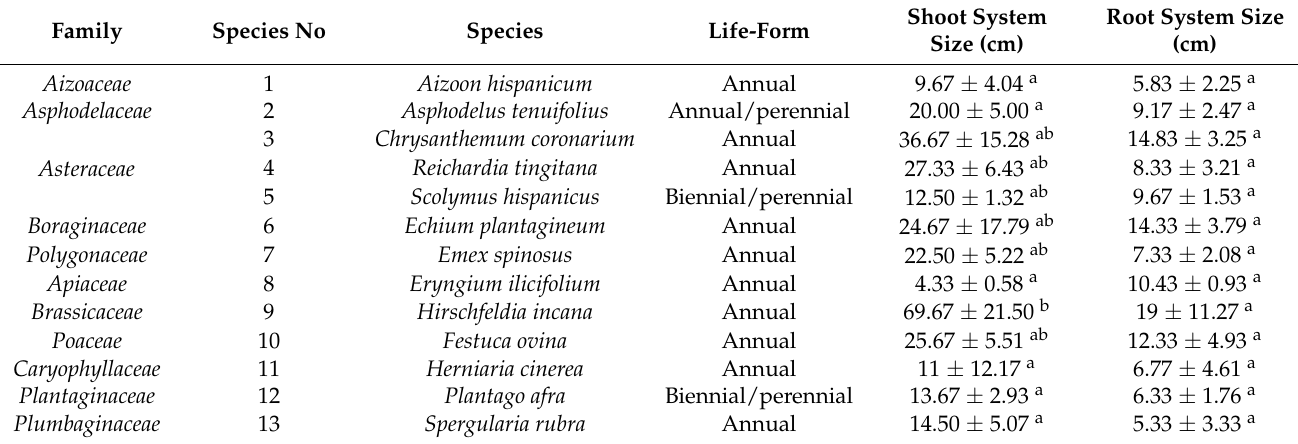
Table 2. List of plants collected in the phosphate wastes of the cover system tested at Kettara mine and their size measurements and life